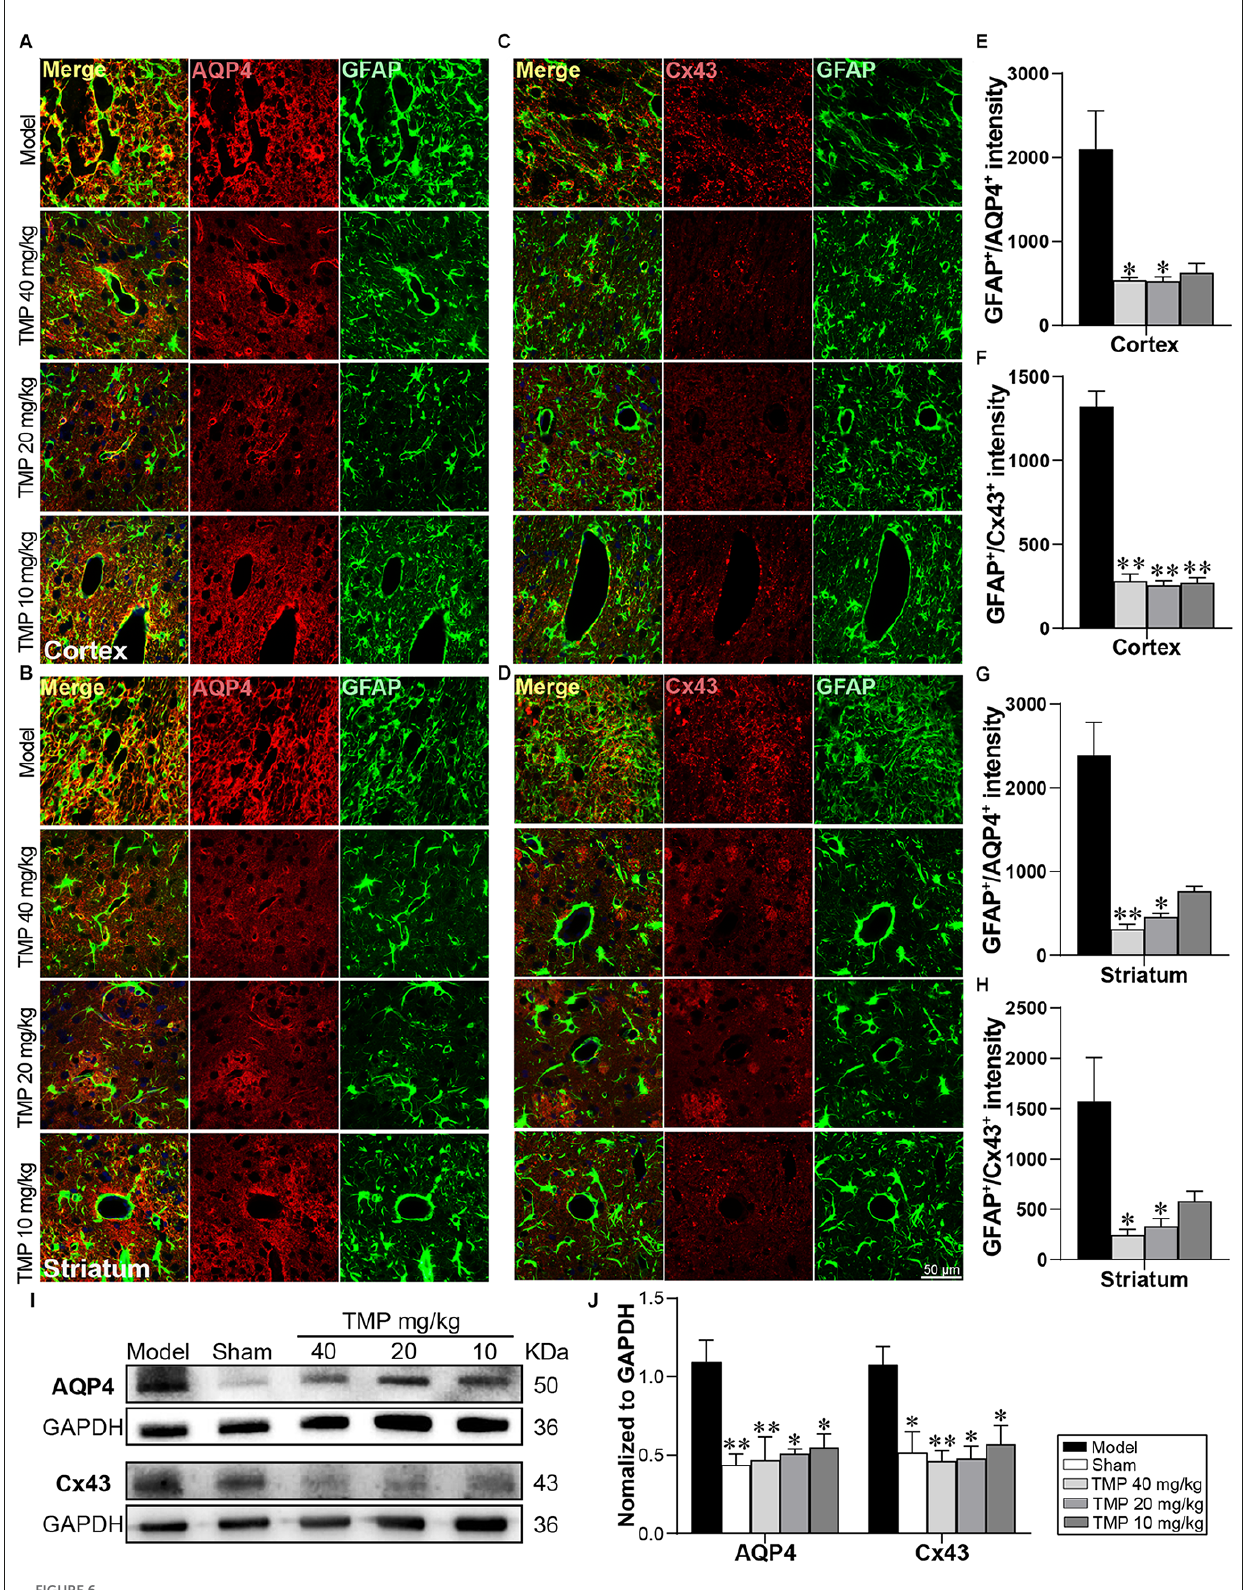
FIGURE6 TMP inhibited the AQP4 and Cx43 expressions in astrocytes of MCAO rats. Immunofluorescence images showed co-localization of (A,B) GFAP (green) and AQP4 (red) and (C,D) GFAP (green) and Cx43 (red) in the periinfarct cortex and striatum ( n = 4). Merge (yellow) indicated GFAP/AQP4 or GFAP/Cx43 co-labeling cells and DAPI (blue) indicated cell nuclei. (E–H) Quantification of GFAP + /AQP4 + and GFAP + /Cx43 + intensities in the periinfarct cortex and striatum of Model and TMP groups. (I,J) Western blot analysis for AQP4 and Cx43 in the periinfarct cortex ( n = 4). ∗ P < 0.05, ∗∗ P < 0.01 vs. Model